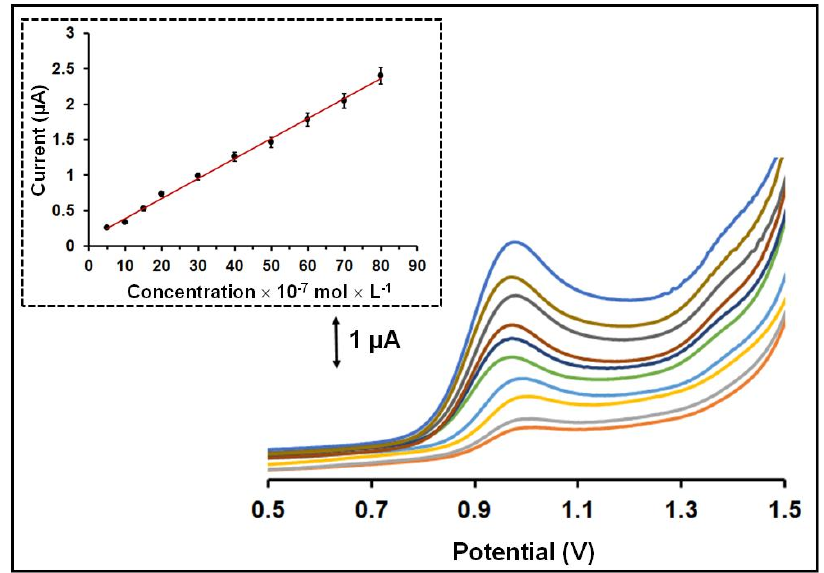
Figure 4. SW voltammograms obtained at the 3D-printed integrated sensor for QF in the concentration range 5 × 10 − 7 –80 × 10 − 7 mol × L − 1 in 0.1 mol × L − 1 acetate buffer (pH 4.8) after accumulation for 120 s. The respective calibration plot for QF is shown as inset. The points in the calibration plot are the mean value ± sd ( n = 3). Applied potential − 0.3 V, accumulation time 120 s. Table 1. Comparison of the 3D-printed device with other QF electrochemical sensors, in terms of linear range and LOD.